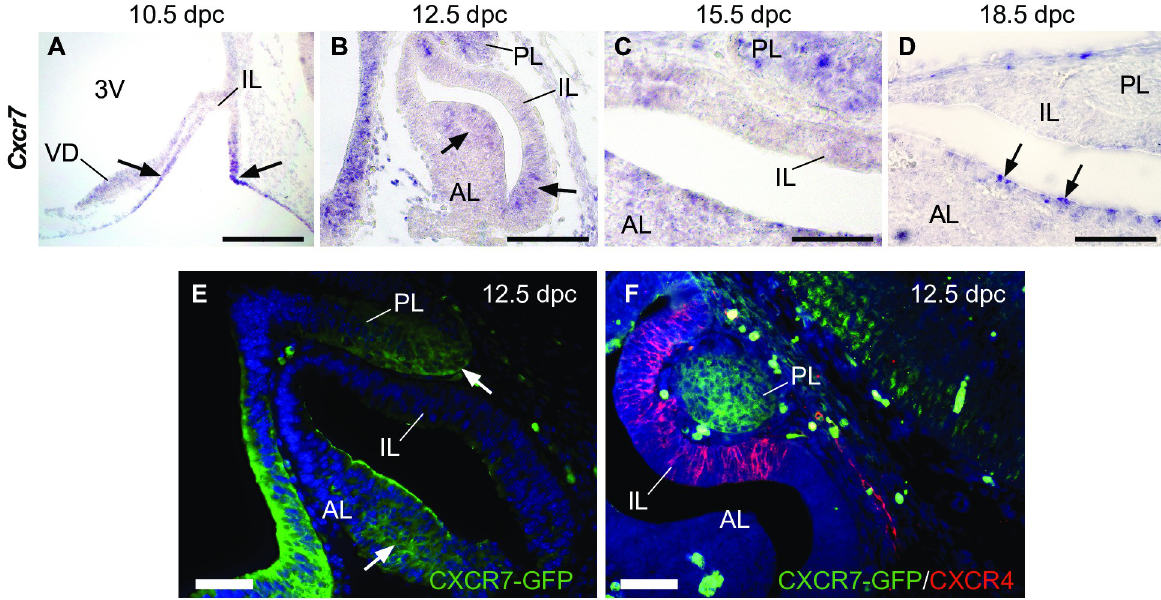
Fig 3. The expression pattern of CXCR7 during murine pituitary development. (A) In situ hybridisation (ISH) shows Cxcr7 mRNA is mainly expressed in ventral regions of RP (arrows) at 10.5 dpc, but not in the IL. (B) At 12.5 dpc, Cxcr7 is expressed in both ventral and posterior regions of the AL lining RP´s cleft (arrows), as well as the PL. (C) At 15.5 dpc, a similar Cxcr7 expression pattern is observed in the PL and AL. (D) At 18.5 dpc, Cxcr7 expression is absent in both IL and PL and becomes restricted to cells in the marginal zone of the AL (arrows). (E) Immunofluorescent staining for GFP in 12.5 dpc Cxcr7 GFP/+ embryos at 12.5 dpc shows protein expression in both AL and PL. (F) Double immunostaining for GFP and CXCR4 shows mutually exclusive expression patterns of both proteins. Counterstain is DAPI. Scale bars: A-B: 200 μ m; C-D: 100 μ m; E-F: 50 μ m. 3V: Third Ventricle; VD: Ventral diencephalon; IL; Intermediate lobe; AL: Anterior Lobe; PL: Posterior Lobe.